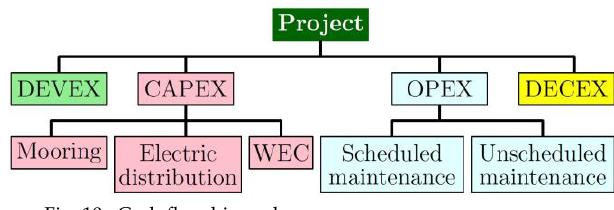
Fig. 10. Cash flow